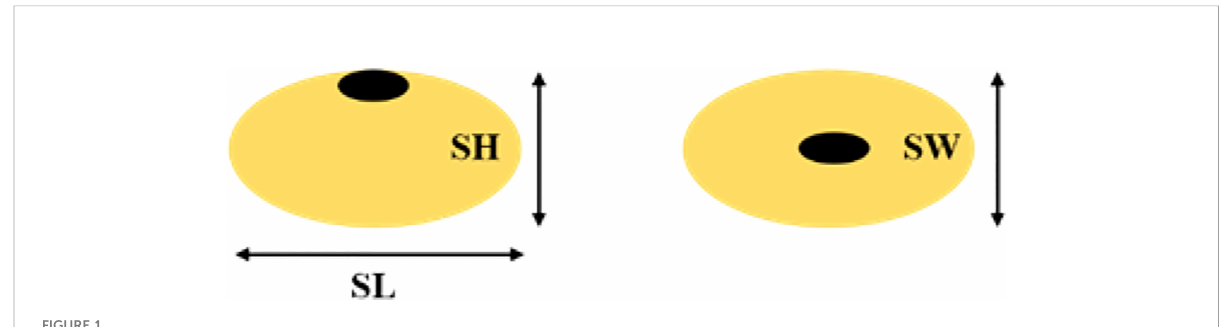
FIGURE 1 Seed Length (SL), Seed Width (SW) and Seed Height